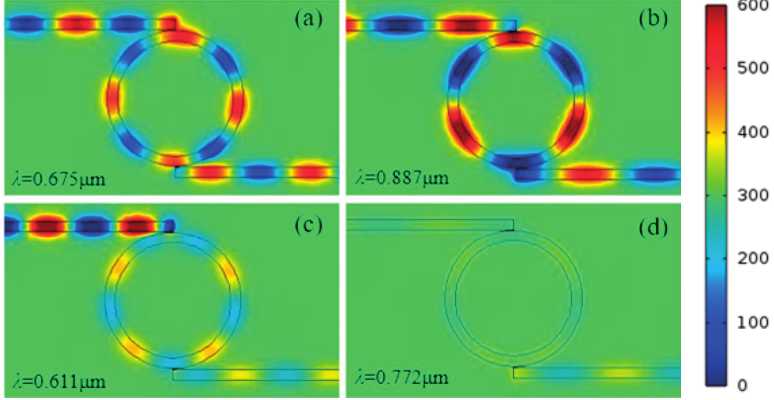
Figure 3. Steady-state distributions of the normalized magnetic field | Hz | at excitation wavelengths of ( a ) 0.675 µm; ( b ) 0.887 µm; ( c ) 0.611 µm; and ( d ) 0.772